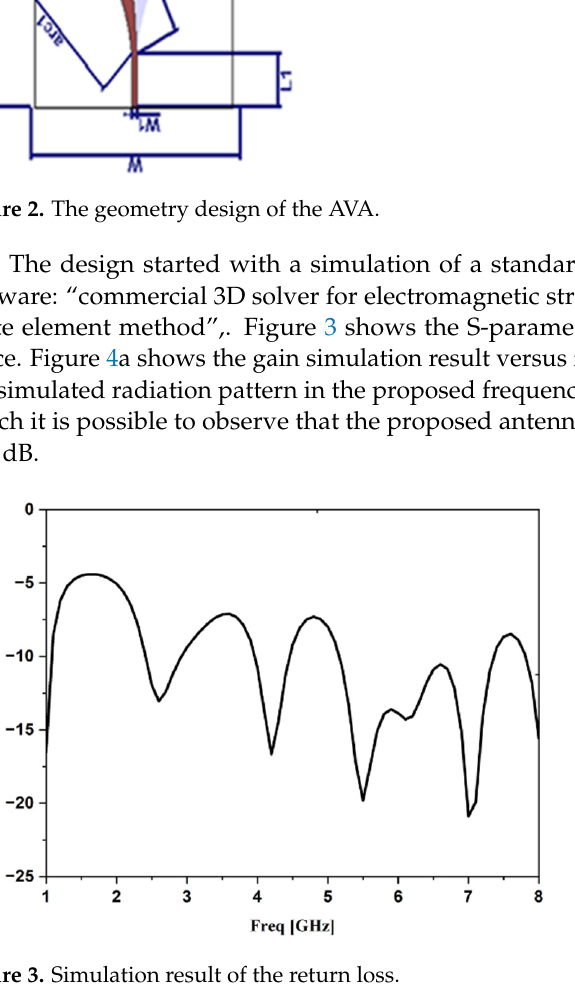
The design started with a simulation of a standard antipodal Vivaldi using HFSS software: “commercial 3D solver for electromagnetic structures from Ansys based on the finite element method”,. Figure 3 shows the S-parameter simulation results in the free space. Figure 4a shows the gain simulation result versus frequency, and Figure 4b presents the simulated radiation pattern in the proposed frequency for tumor detection (5 Figure 3. Simulation result of the return loss. Figure 3. Simulation result of the return loss. GHz), in which it is possible to observe that the proposed antenna is directional with a gain equal to 6 dB.